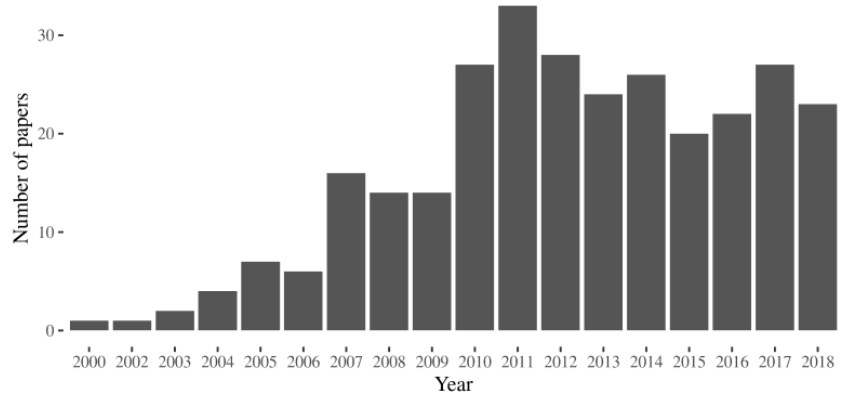
Figure 1. The number of the research articles indexed in Scopus that cite the term “pharmacological chaperone” in the title, in the abstract or the keywords and a specific disease.